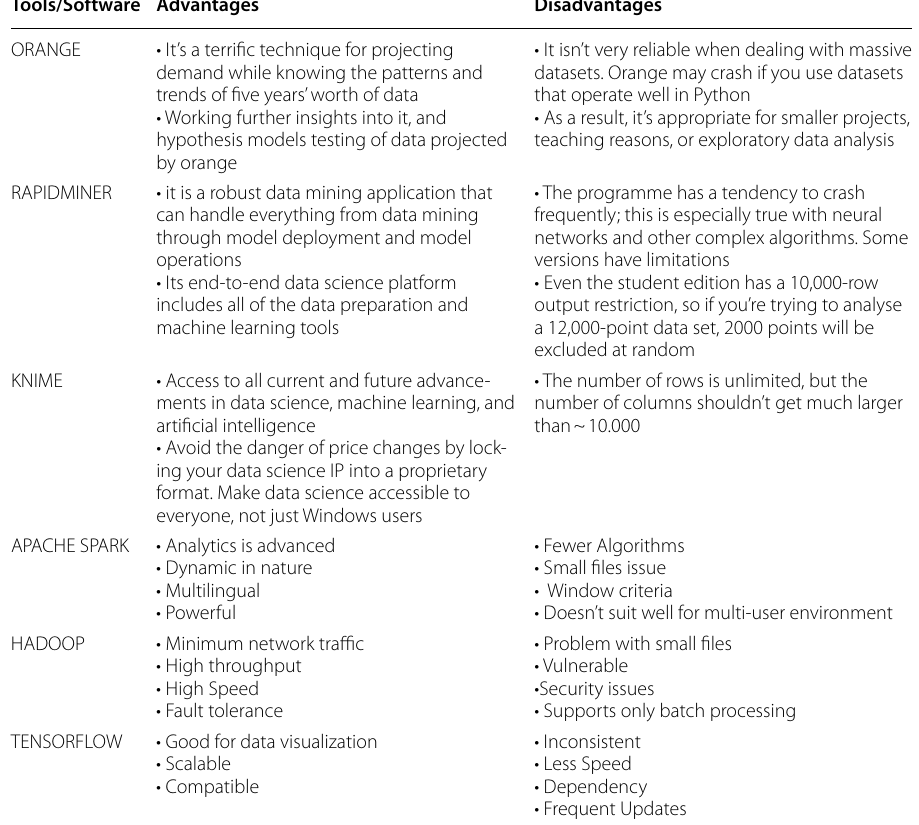
Table 2 Overview of Software handling Big Data Tools/Software Advantages Disadvantages